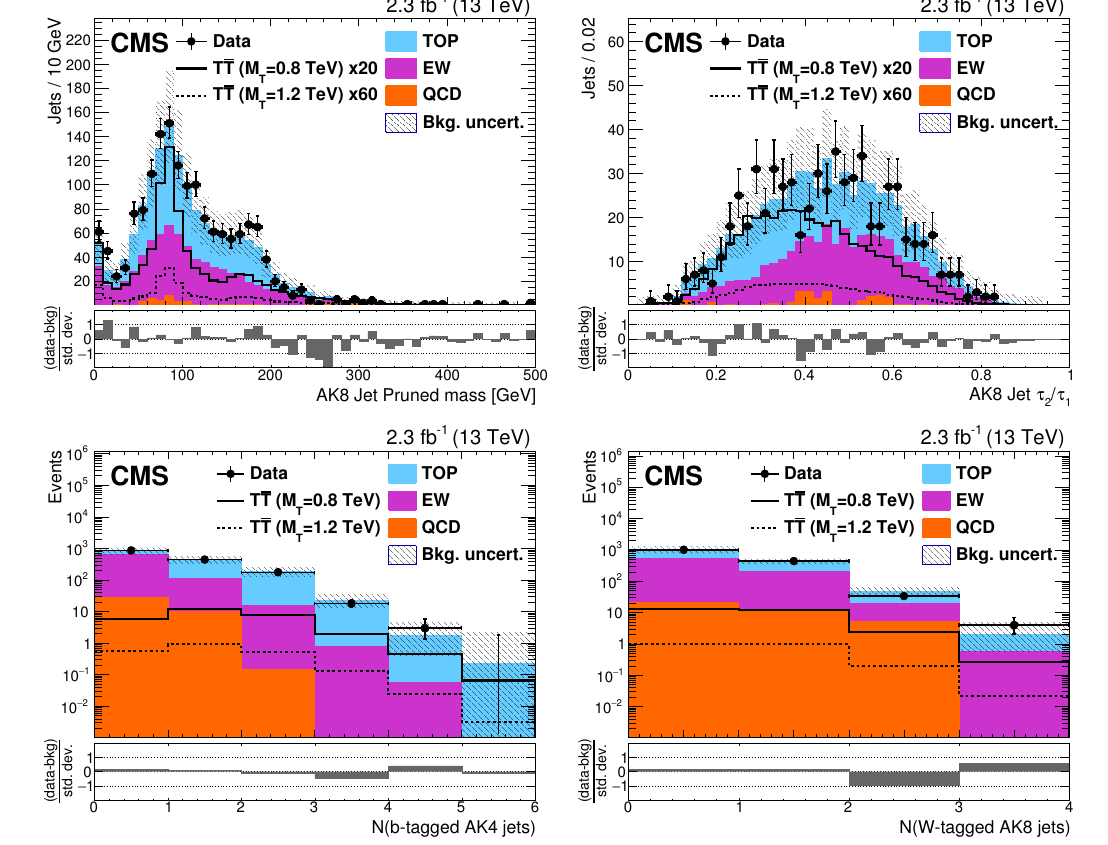
Figure 6 . Distributions of (left-to-right, upper-to-lower) pruned jet mass for AK8 jets with (cid:28) 2 =(cid:28) 1 < 0 : 6, (cid:28) 2 =(cid:28) 1 for AK8 jets with pruned mass within 65{105 GeV, number of b-tagged AK4 jets, and number of W-tagged AK8 jets in the boosted W channel with all categories combined. Also shown are the distributions of TT signal events with T quark masses of 0.8 and 1.2 TeV, scaled by factors of 20 and 60, respectively, in the upper (cid:12)gures. The uncertainty in the background includes the statistical and systematic uncertainties described in section